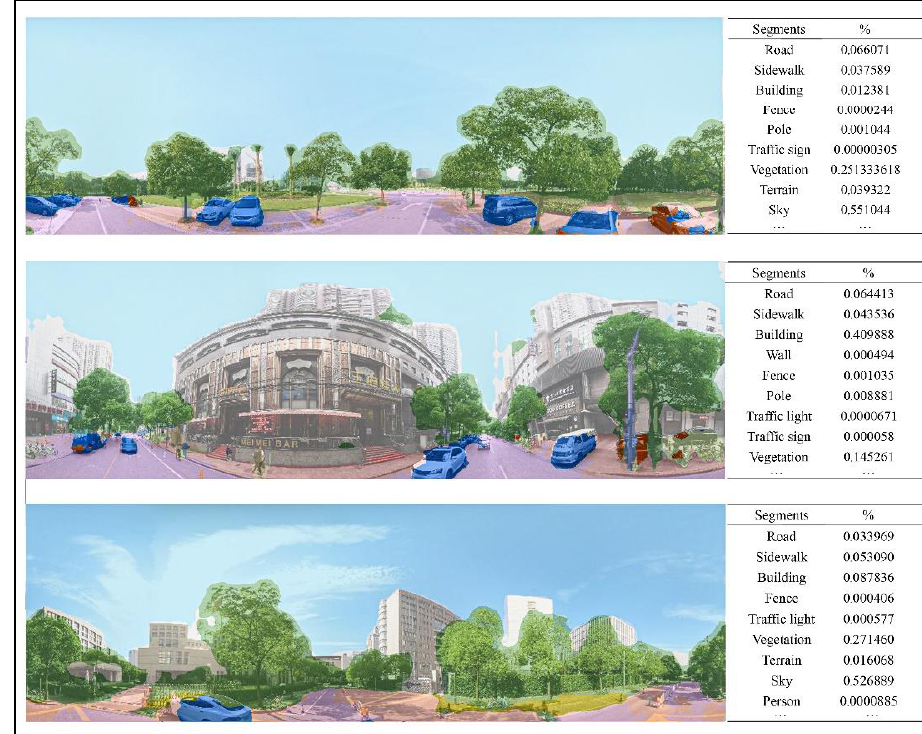
Figure 5. Summary table of the segmentation results.